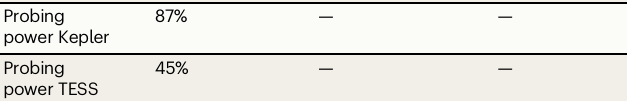
Pre-main sequence (radius=2.8 R ⊙ , see methods, subsection stellar evolution models)